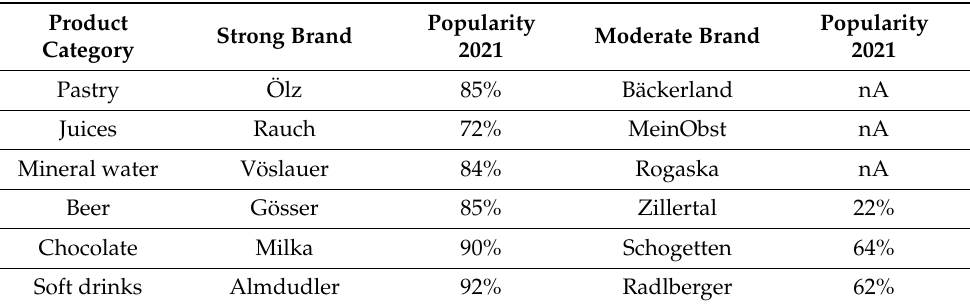
Table 1. Stimuli in Experiment 1 and Experiment